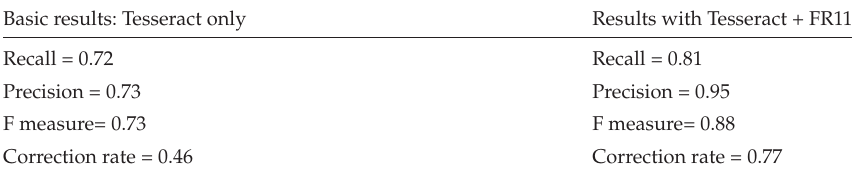
Table 6: Combined P/R and corrections rate results of Tesseract and ABBYY FineReader 11. Basic results: Tesseract